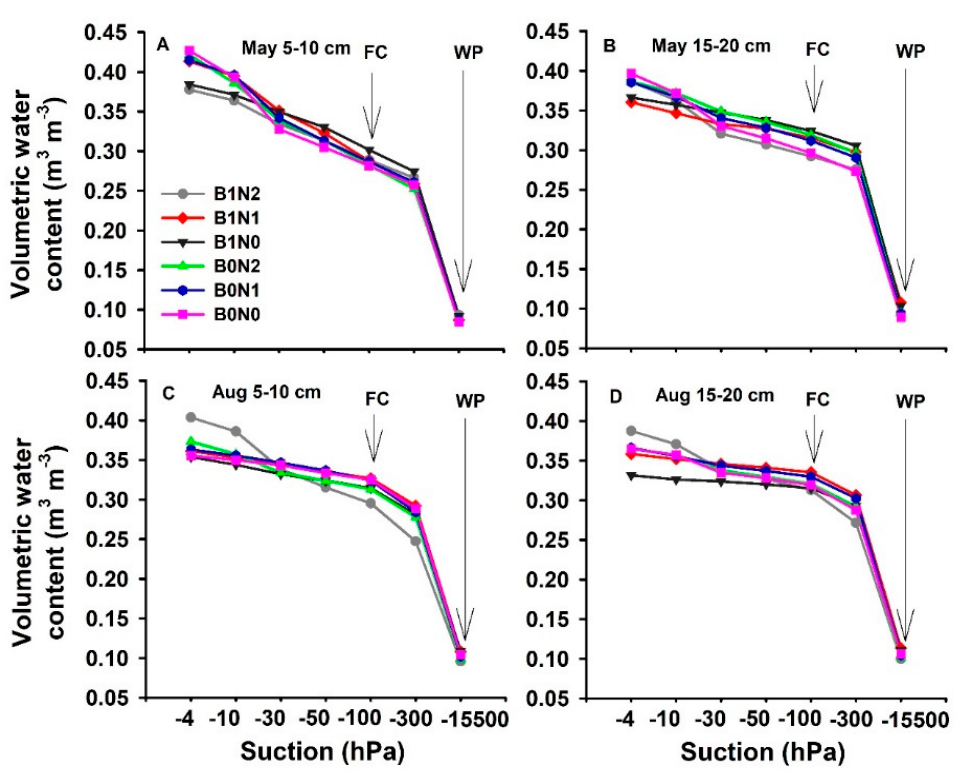
Figure 3. Effect of different treatments on VWC (volumetric water content), FC (field capacity), and WP (plant wilting point) ( A ) in May at 5–10 cm depth, ( B ) in May at 15–20 cm depth, ( C ) in August at 5–10 cm depth, ( D ) in August at 15–20 cm depth.